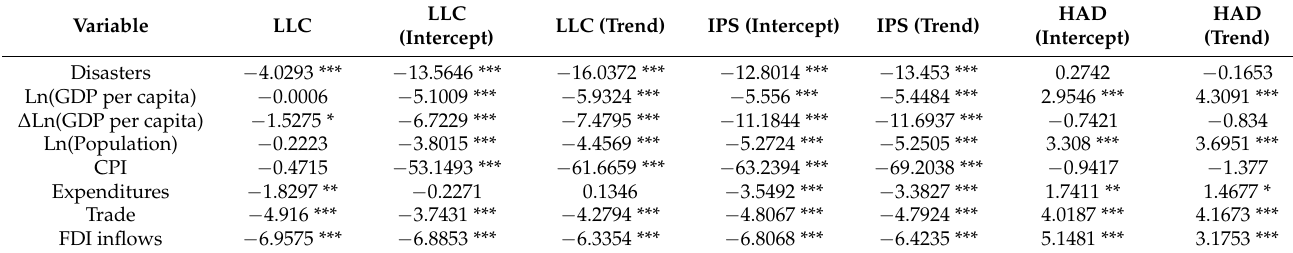
Table A2. Unit root tests of used